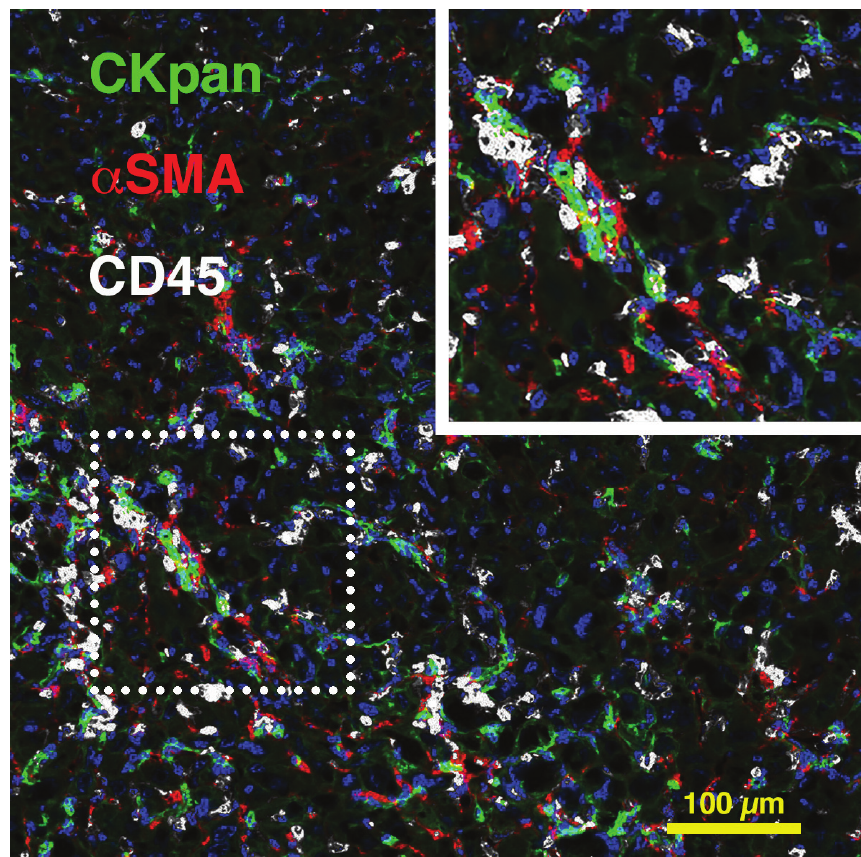
Figure 1. The injury and regeneration niche during chronic liver injury. Murine chronic liver injury induced by feeding a choline-deficient, ethionine-supplemented diet 15 leads to formation of an injury and regeneration niche, involving CKpan + ductular cells and LPCs (green), α SMA + hepatic stellate cells (red) and CD45 + inflammatory cells (white). DAPI was used for nuclear